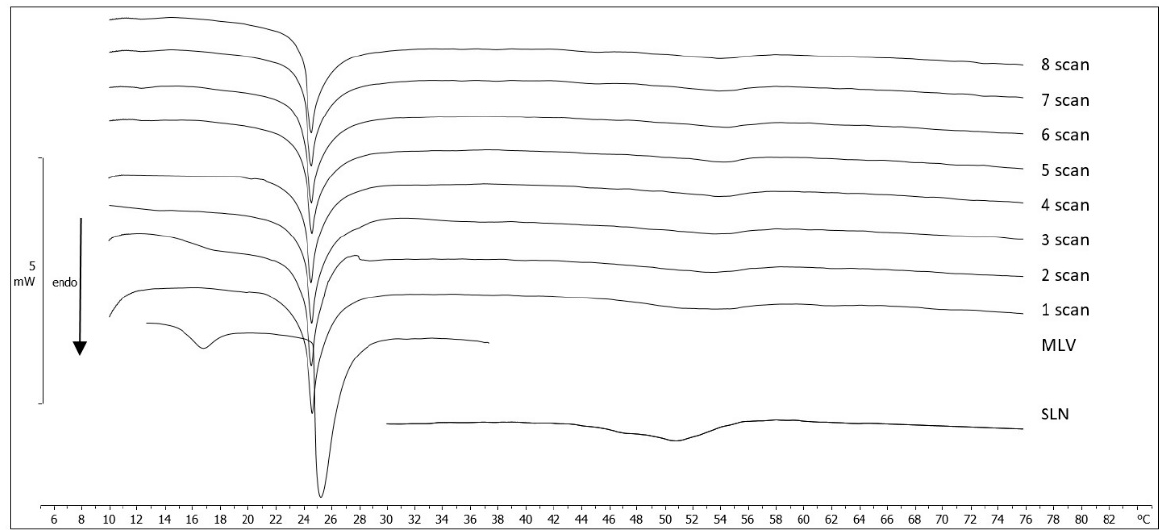
Figure 6. Calorimetric curves, in heating mode, of MLV put in contact with SLN 8 at increasing incubation time. There are 68 min between one scan and the next.